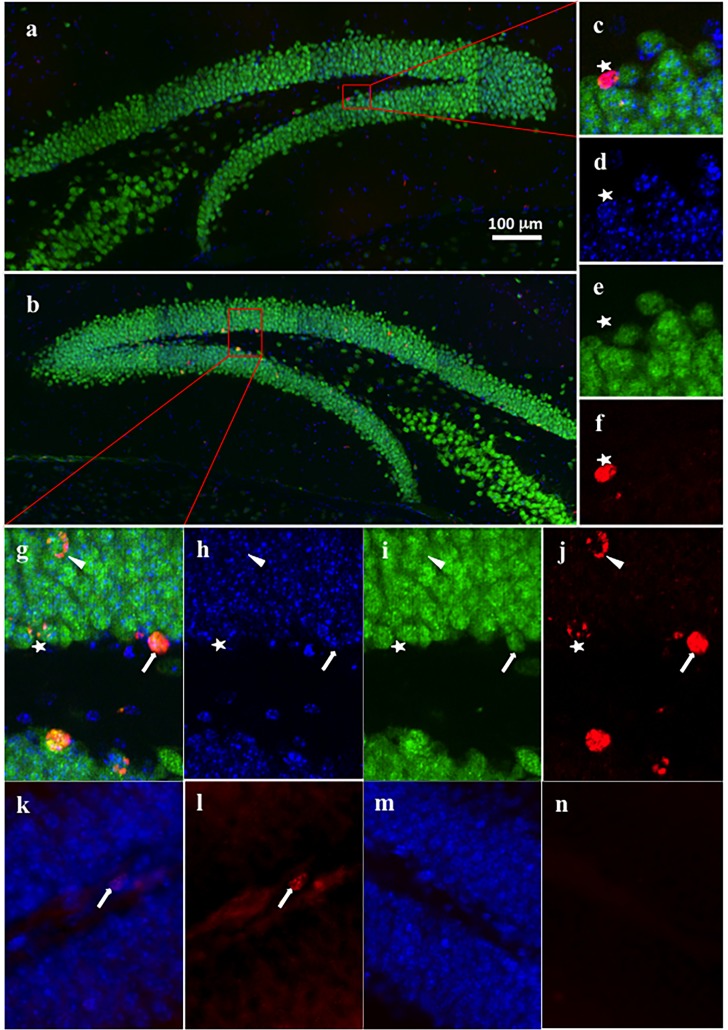
Representative images of BrdU incorporation within mature neurons in the dentate gyrus.A representative image of the dentate gyrus from a Non-Runner (a) and a Runner (b). A close up image from the section of the dentate gyrus from the Non-Runner (c), and the Runner (g), DAPI stain showing nuclei (d and h), NeuN stain showing mature neurons (e and i) and BrdU staining showing newly born cells (f and j). The line arrow points to a mature neuron (stained with NeuN) with complete BrdU incorporation, these cells have not undergone cell division after the uptake of BrdU. The arrow head points to a mature neuron (stained with NeuN) with only partial BrdU incorporation, these cells have divided following BrdU injection or were born late in the accumulation window. The star points to a cell with BrdU incorporation but no co-localisation with NeuN and is therefore not a neuron (not analysed). Blue–DAPI, Green–NeuN, Red–BrdU. A representative image of Ki67 staining (arrow, k and l) and control (m and n). Blue–DAPI, Red–Ki67.